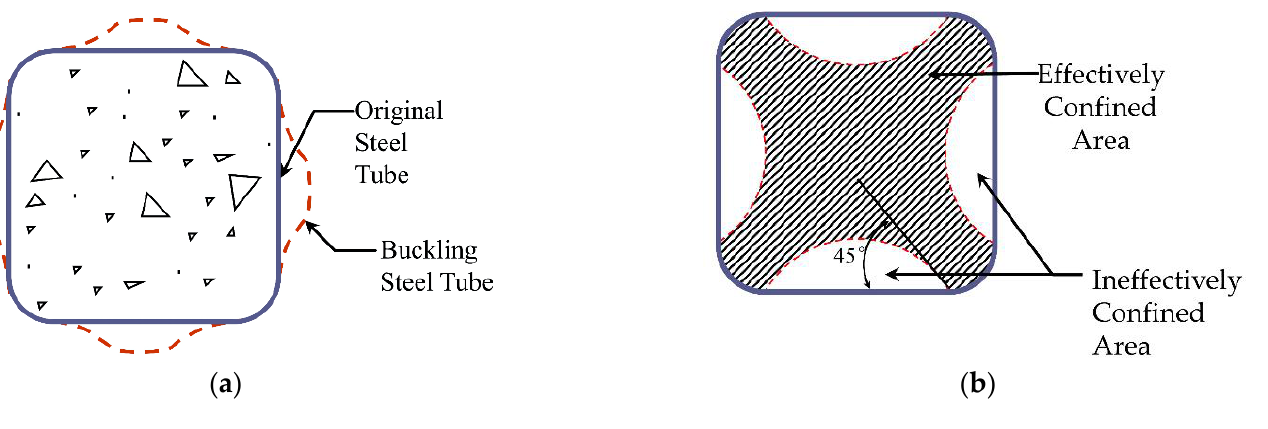
Figure 16. ( a ) Buckling characteristics of square steel tube under axial load; ( b ) effectively confined concrete in a square column.